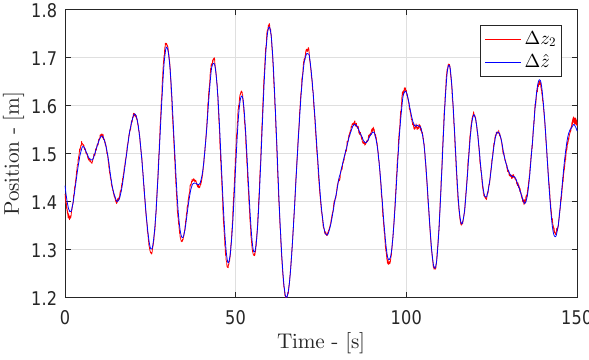
Figure 16: EQKF performance for quaternion coeffi- cient q z .